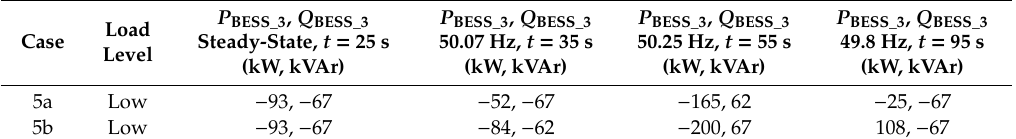
Table 6. BESS 3 active ( P BESS_3 ) and reactive ( Q BESS_3 ) power during over- and under-frequency events in di ff erent cases (Figures 1 and 2, Tables 2 and 3).